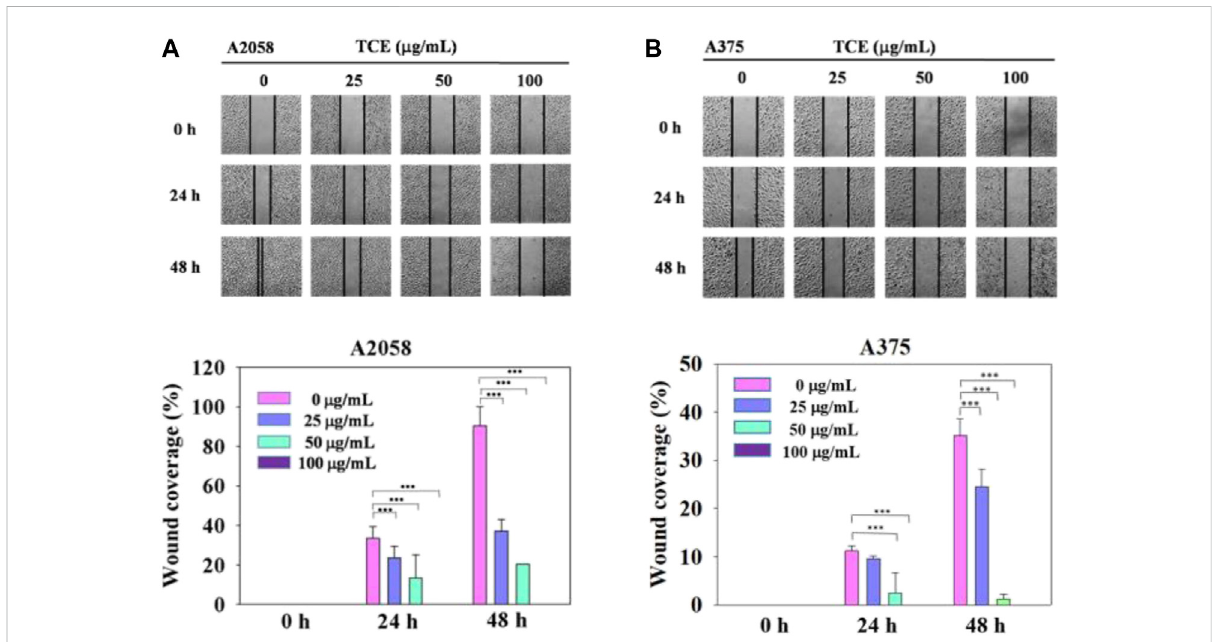
FIGURE 4 The effects of TCE on the cell migration of A2058 and A375 cells. (A,B) Photographs showed wound closure of A2058 and A375 cells treated with TCE (0, 25, 50, 100 μ g/mL) and 0, 24, 48 h. Cell wound healing assay was performed as described in the Materials and Methods. % Wound coverage wasdetermined bytherateofcells movingforwardthescratched areaupontime.Thevalues ofpercentagewound closure± SDofatleast three independent experiments. Comparisons were performed using two-way ANOVA with post hoc Turkey ’ s test (*** p <